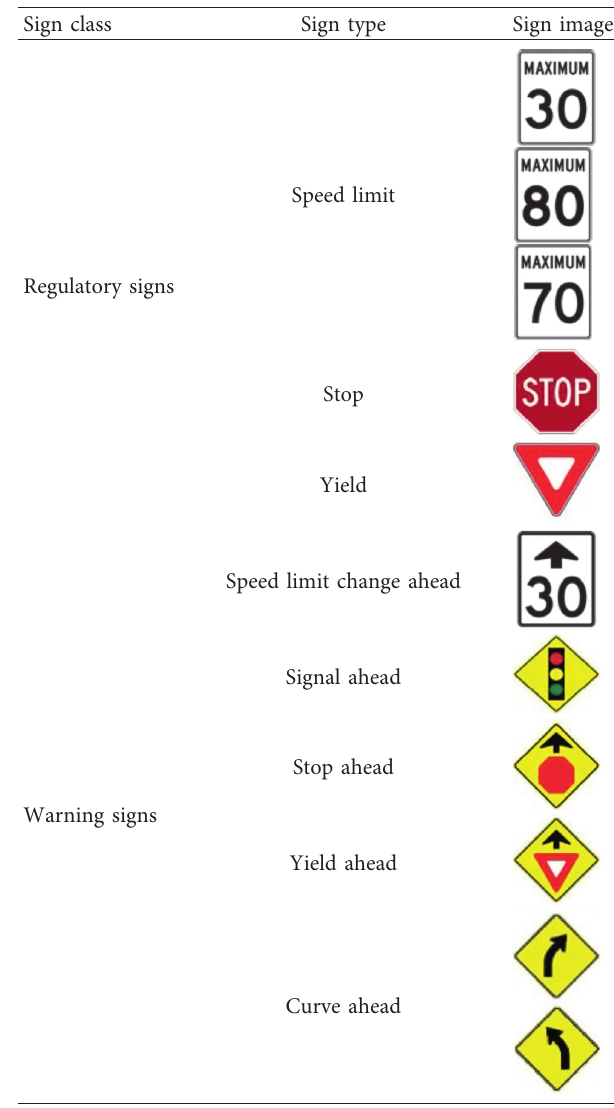
Table 1: Selected traffic signs for this